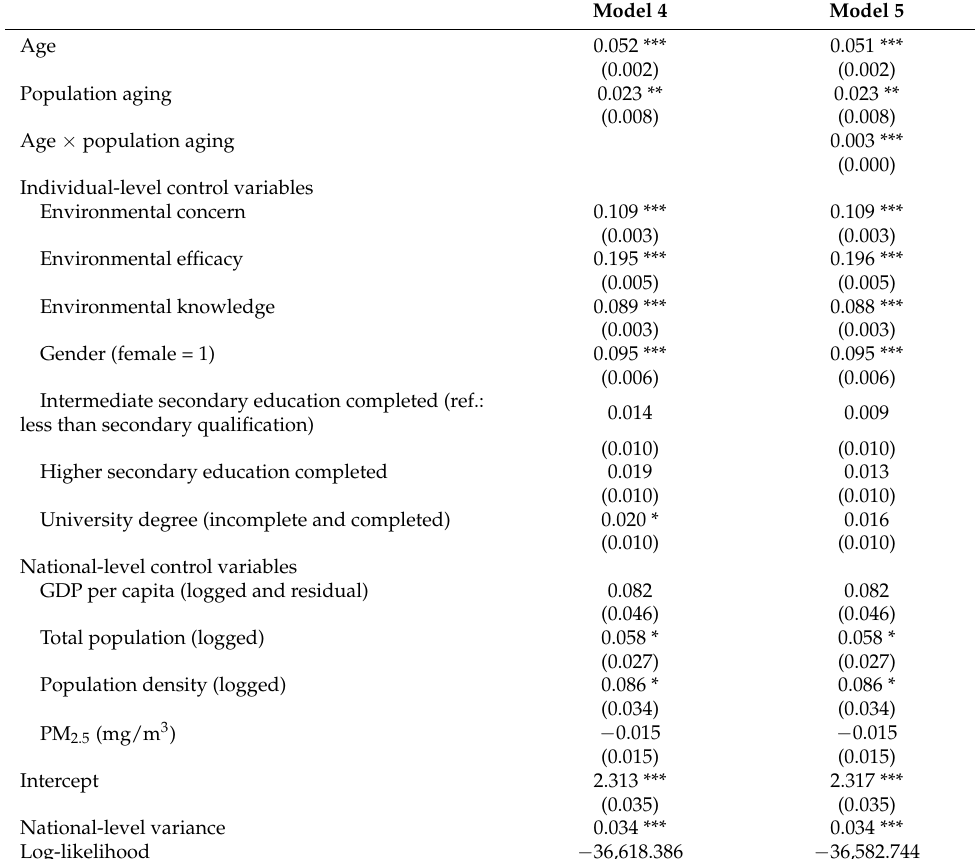
Figure 1. The predicted effect of age on pro-environmental behavior, ISSP2010. This figure is based on Model 3, Table 3. The reference group is people aged 65 to 74. The numbers above the lines represent the predicted effect size. The red lines indicate significant results ( p < 0.05) and the green lines indicate non-significant results. Table 4. Multilevel linear models predicting the effect of population aging on pro-environmental behavior,